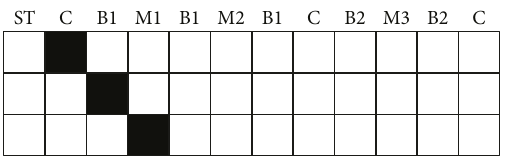
Figure 6: Evolution representing Robot 2 moving a part from the conveyor to Bu ff er 1.